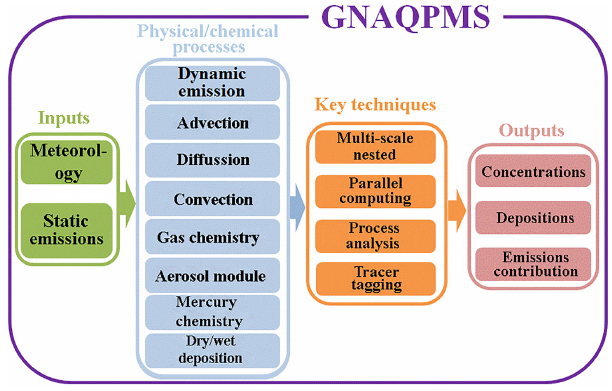
Figure 1. Framework of the Global Nested Air Quality Prediction Modeling System